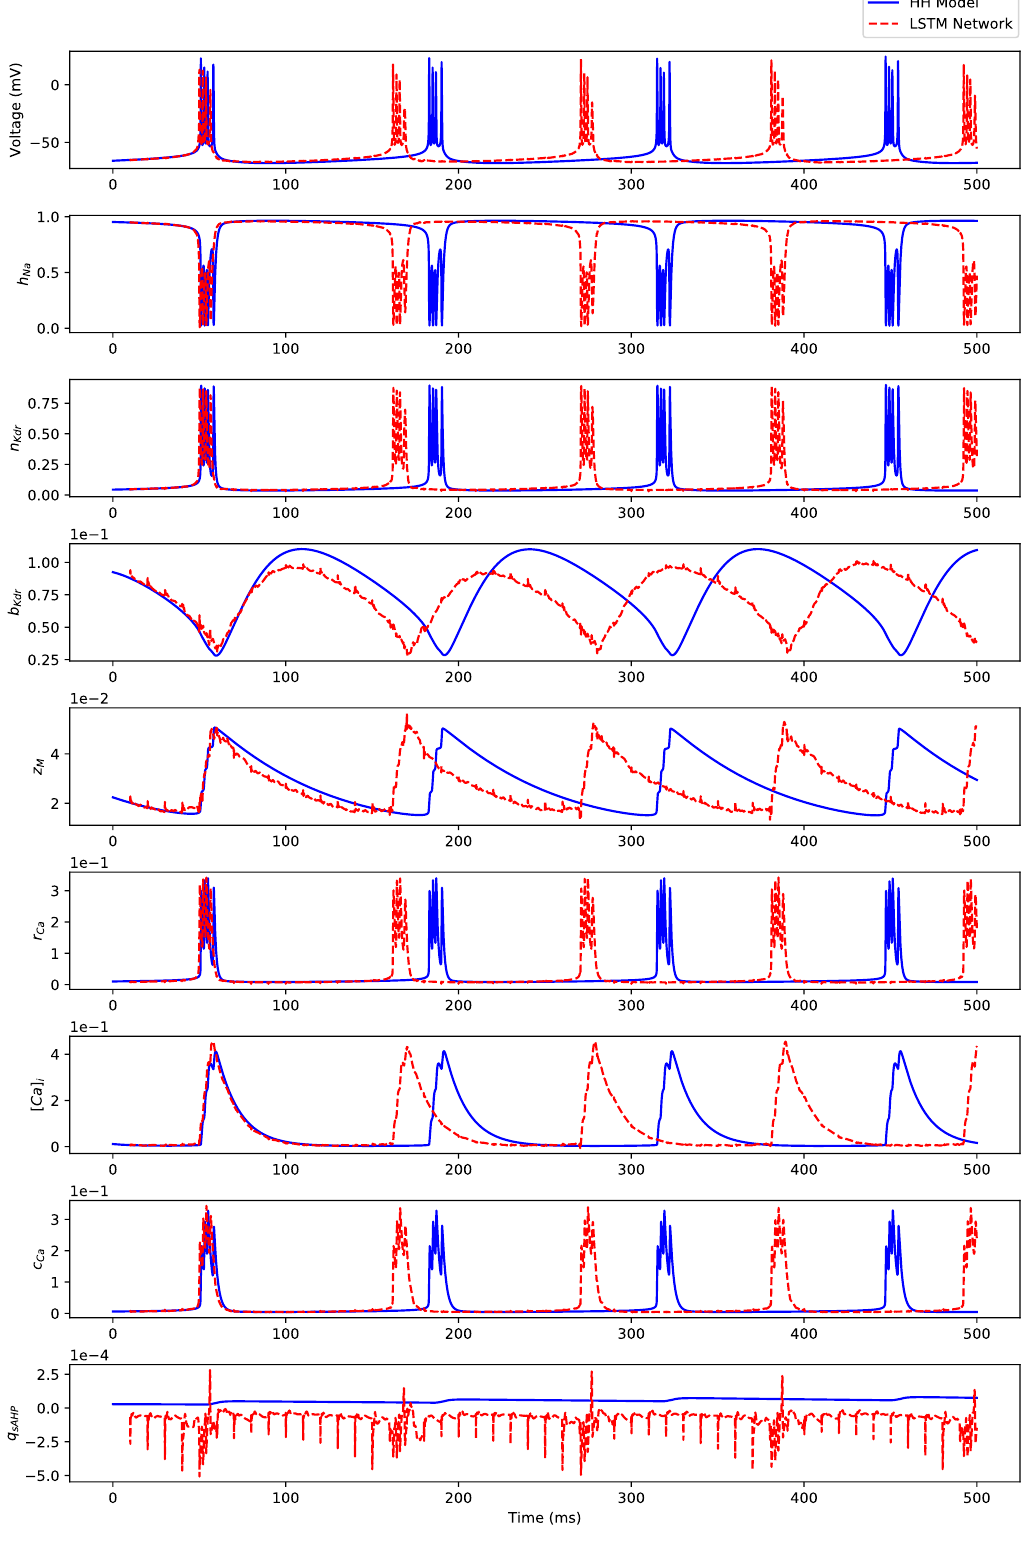
Figure A13. Comparison between the Hodgkin-Huxley model (“HH Model”) states’ dynamics and the iterative predictions of states’ dynamics using the 100 timesteps predictive horizon-based deep LSTM neural network (“LSTM Network”) in response to I = 0.5